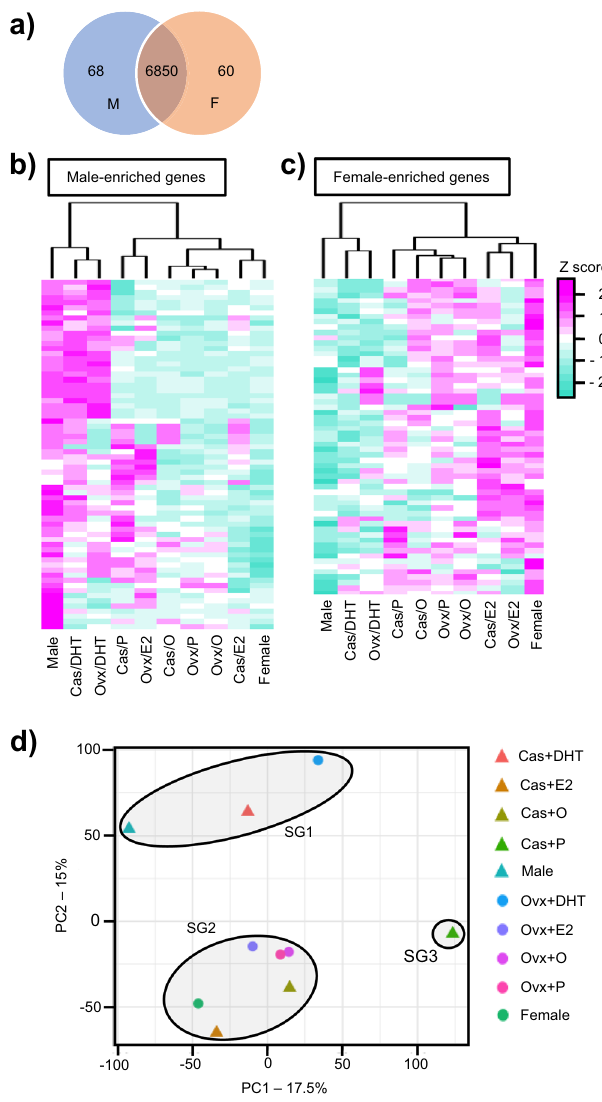
Fig. 2 Sexually dimorphic gene expression in quadriceps type IIB fi bers. a A total of 6978 genes whose CPM values were more than 10.0 in either of the two sexes (sham-operated males or females) were analyzed. Overall, 68 and 60 genes were found to be male enriched (M) and female enriched (F) by more than 2.0-fold, respectively. b , c Heatmaps of the male-enriched and female-enriched gene expressions in the 10 experimental mouse groups (see text and Supplementary Fig. 2) are shown. Color gradients correspond to the z -score as indicated at the right. d Results of principal component analysis of whole gene expression in the 10 groups are shown. PC1 and PC2 account for 17.5% and 15% of the percentage contribution to the variance, respectively. As indicated by closed ovals, the 10 groups are divided into three subgroups (SG1 –